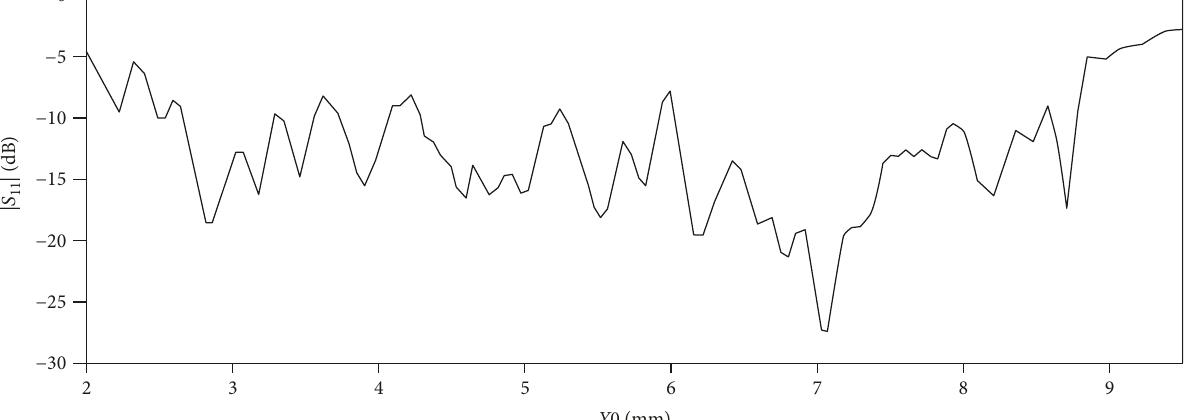
Figure 10: Simulation results for the re fl ection coe ffi cient dependence of the inset feed length Y with the shorting